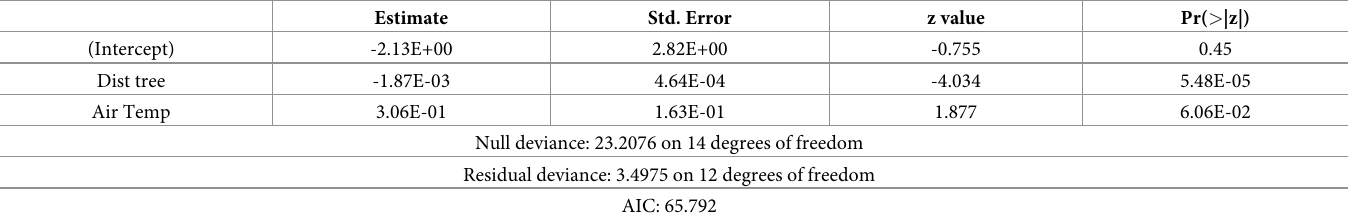
Table 5. Statistics of the Generalized Linear Model (GLM) used to assess the relationship between the explanatory variables [DBH, tree height, distance between trees, DAH, shrub height, distance between shrubs, percentage of litter; green cover, bare soil, depth of litter, clay, sand, lime, moisture] and the functional